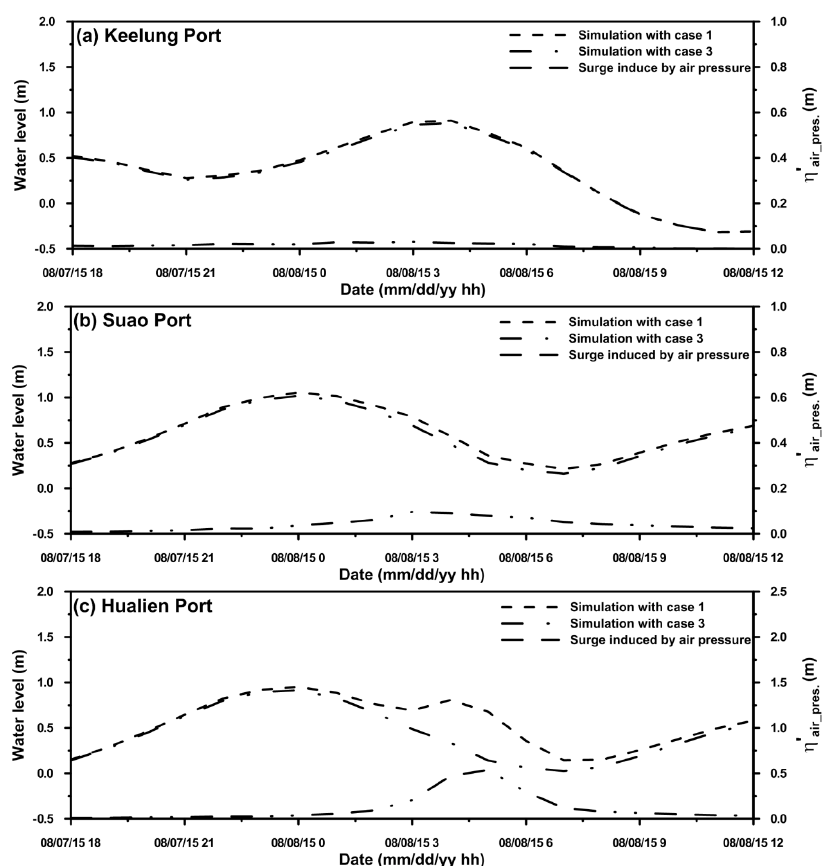
Figure 12. Comparison of the simulated water level between Case 1 and Case 3 and the calculated air pressure-induced surge at: ( a ) Keelung Port; ( b ) Suao Port; and ( c ) Hualien Port during Typhoon Soudelor (2015).